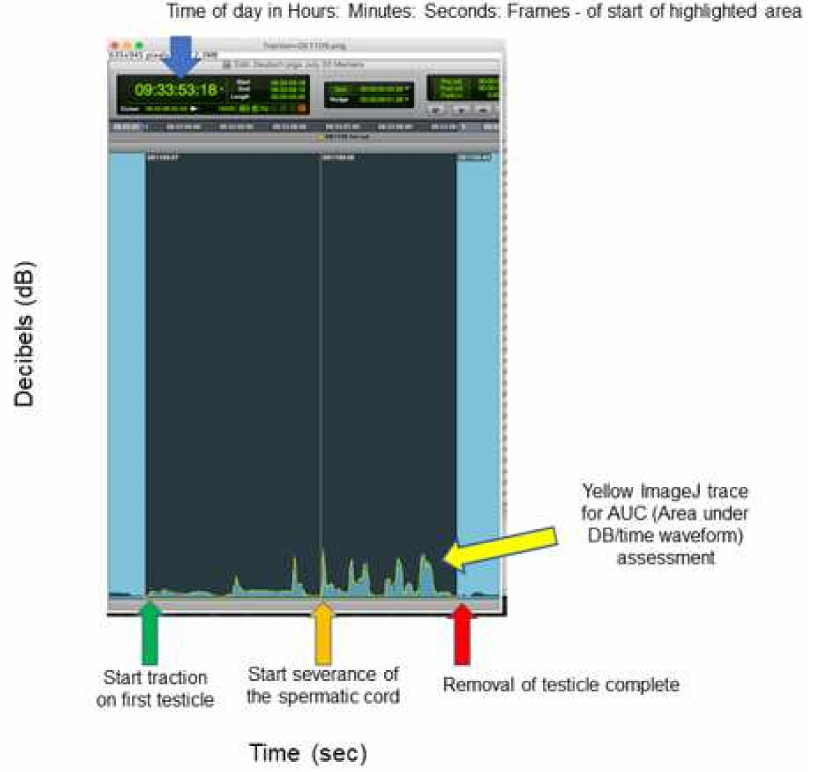
Figure 1. Representative screenshot of dB/time waveform, and yellow ImageJ tracing for AUC (area under the dB/time waveform) analysis. The image shows the black highlighted section encompassing the time from first commencing traction, until completing removal of the first